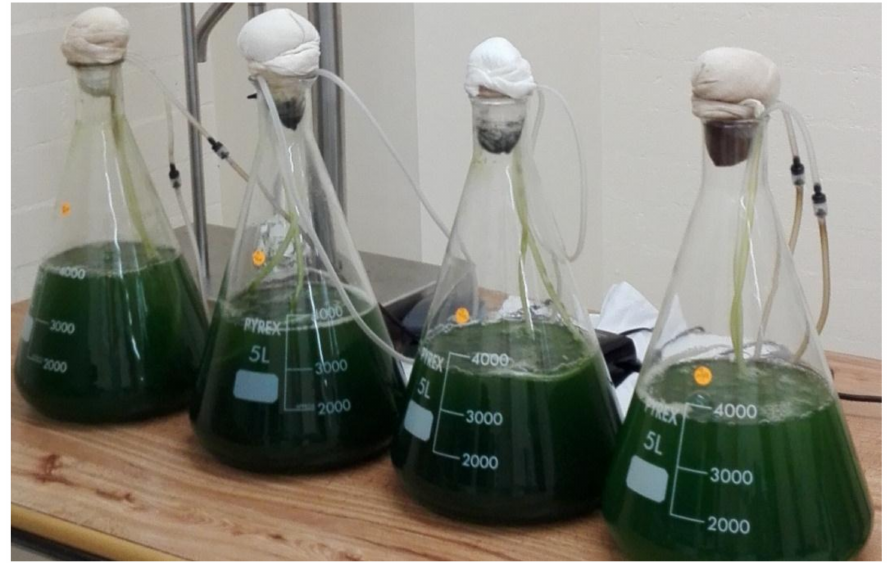
Figure 7. Microalga